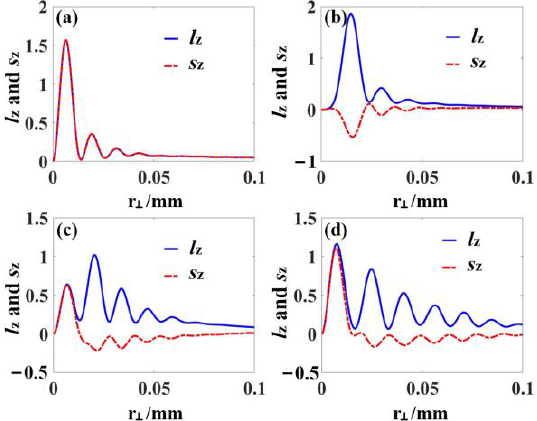
Figure 4. The focal plane AM density distributions on r ⊥ axis under ( a ) L = 0 mm, ( b ) 10 mm, ( c ) 20 mm and ( d ) 30 mm. The results are relative to ε 0 /2 ω.